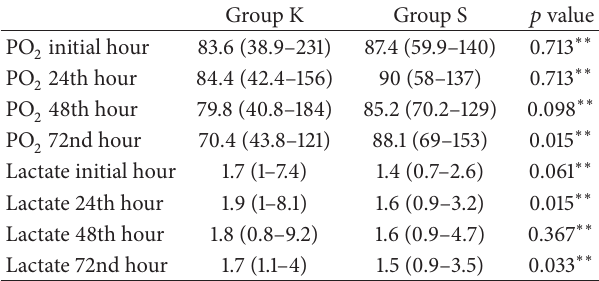
Table 2: Blood gas analysis.